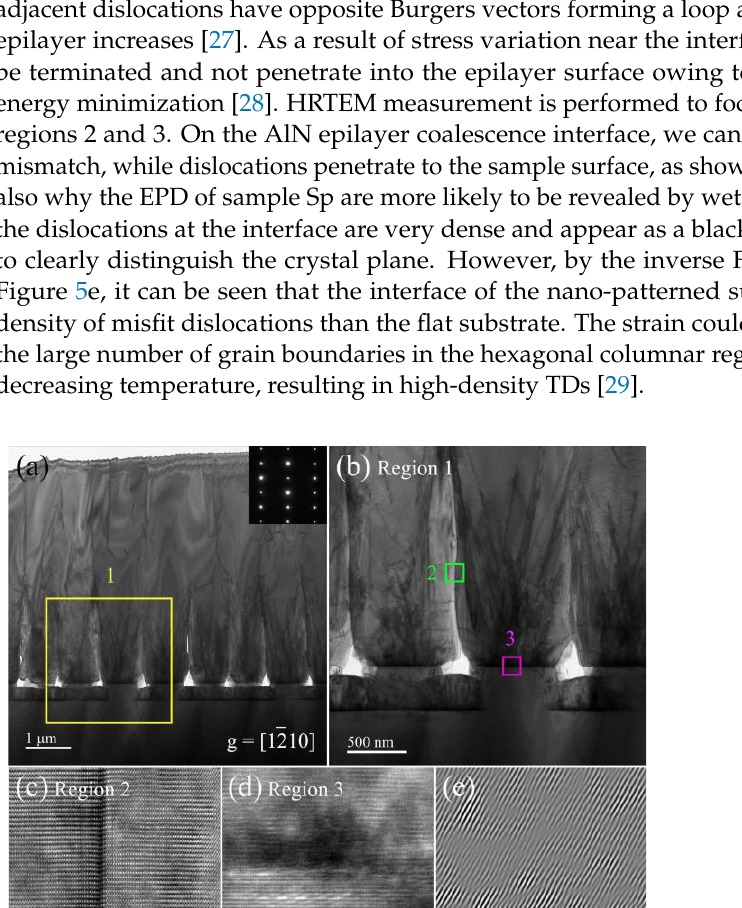
Figure 5. ( a ) Cross-sectional TEM image of AlN sample Sp. ( b ) Partial enlarged image corresponding to region 1 in ( a ). ( c , d ) HRTEM images focused on regions 2 and 3. ( e ) Inverse fast Fourier transform image for region 3.